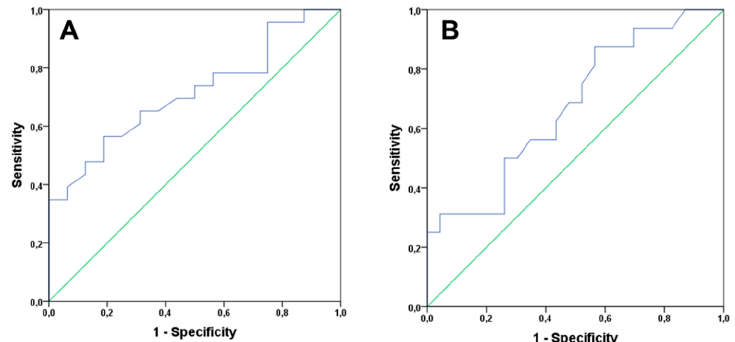
Figure 5. Receiver operating characteristic (ROC) curve for lymphocyte count ( A ) and IL-6 concentration ( B ) and the ability to discriminate between patients who progressed or otherwise in frailty syndrome.